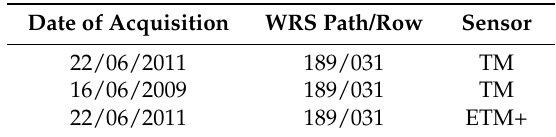
Table 1. Acquisition date of the selected scenes and implemented